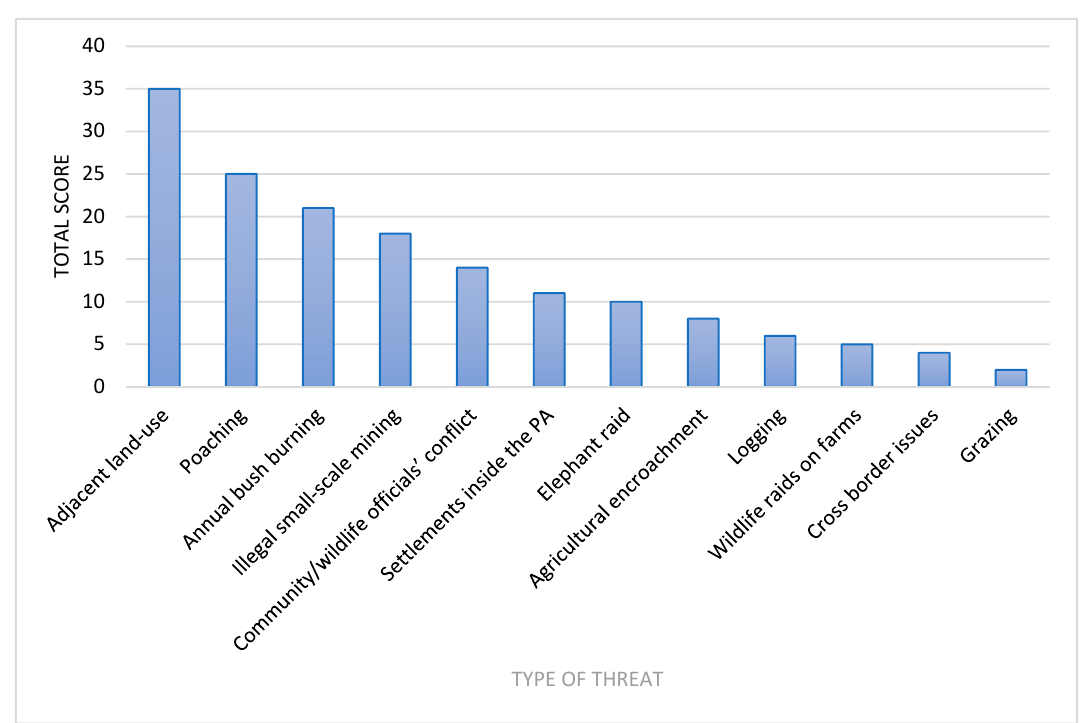
Figure 3. Analysis of Threats Facing Neighboring Communities of Protected Areas.